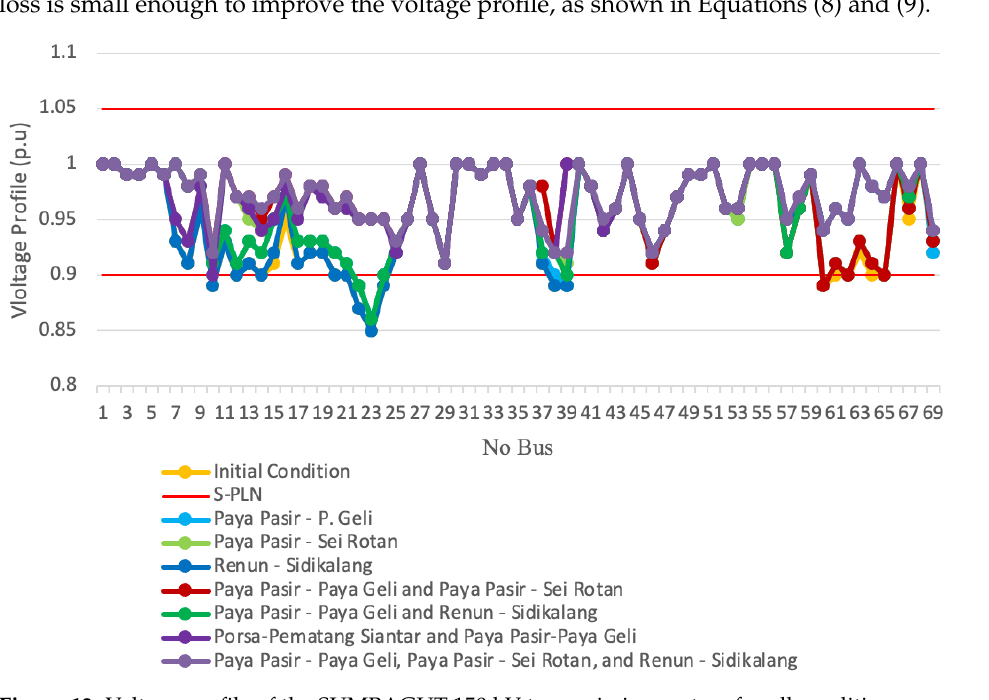
Figure 13. Voltage profile of the SUMBAGUT 150 kV transmission system for all conditions.